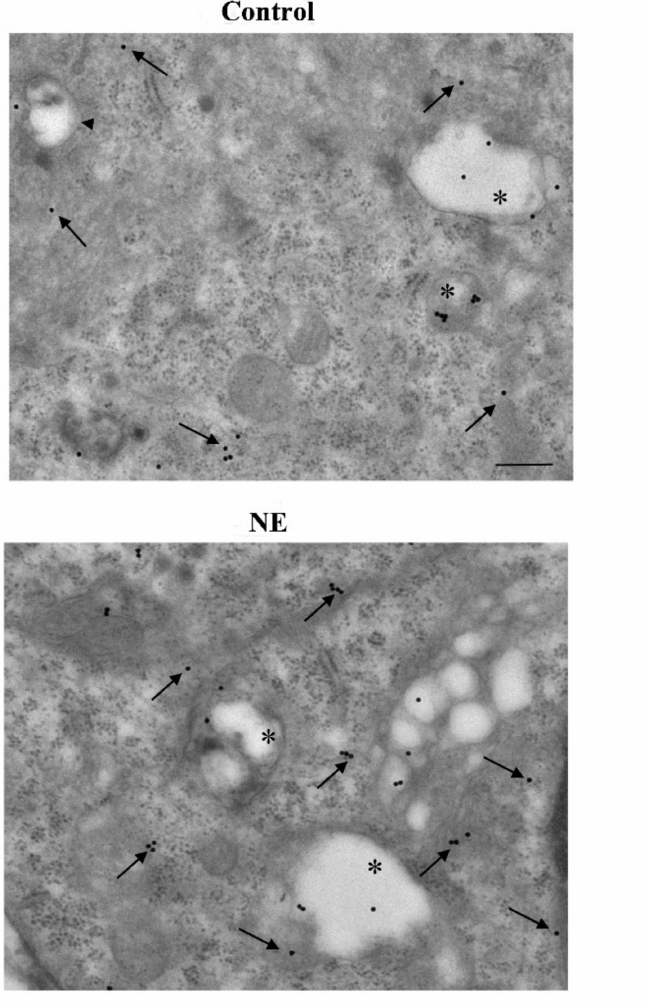
Figure 15. Representative TEM micrograph of LC3 compartmentalization following NE and Meth (high magnification). Representative TEM micrographs at high magnification of Control, Meth (50 µ M), NE (5 nM), or NE (5 nM) + Meth (50 µ M)-treated cells. Images show autophagy-like vacuoles (arrowhead); autophagy vacuoles (asterisk for LC3); and cytosolic LC3 particles (arrow pointing 20 nM immunogold particles). Cells were fixed for TEM analysis 72 h after Meth administration. In the combined treatment, NE was administered 30 min before with Meth. Scale bar = 200